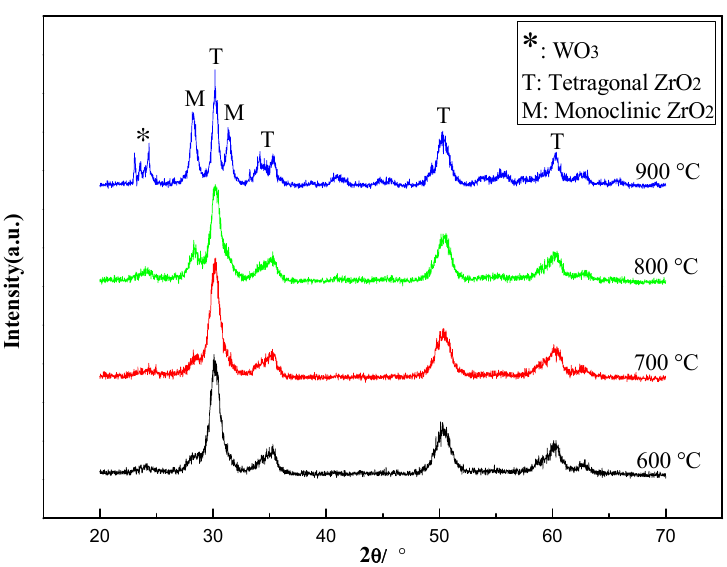
Figure 8. XRD patterns of the Cr-Pt/WZ catalyst calcined at 600~800 °C.